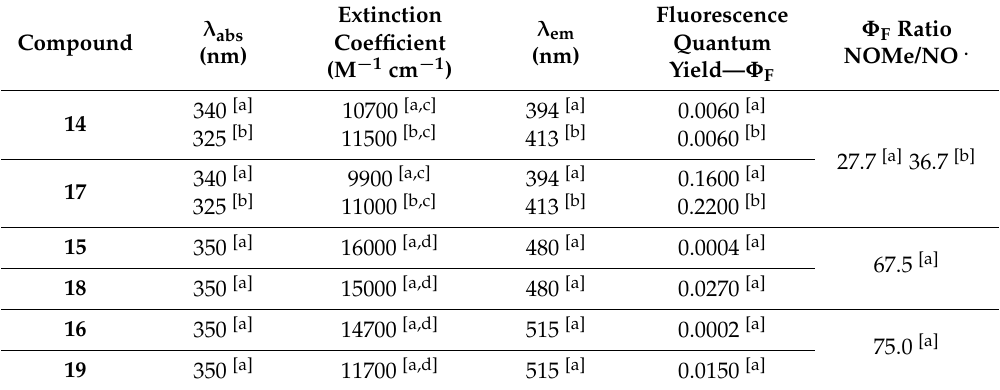
Table 1. Photophysical properties of FNs 14 – 16 and fluoroquinolone–methoxyamines (FMs) 17 – 19 .